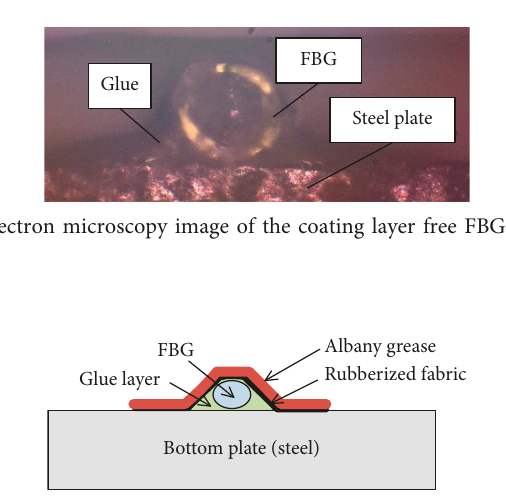
Figure 9: Schematic diagram of strain transfer for the bottom grating sensor of the test